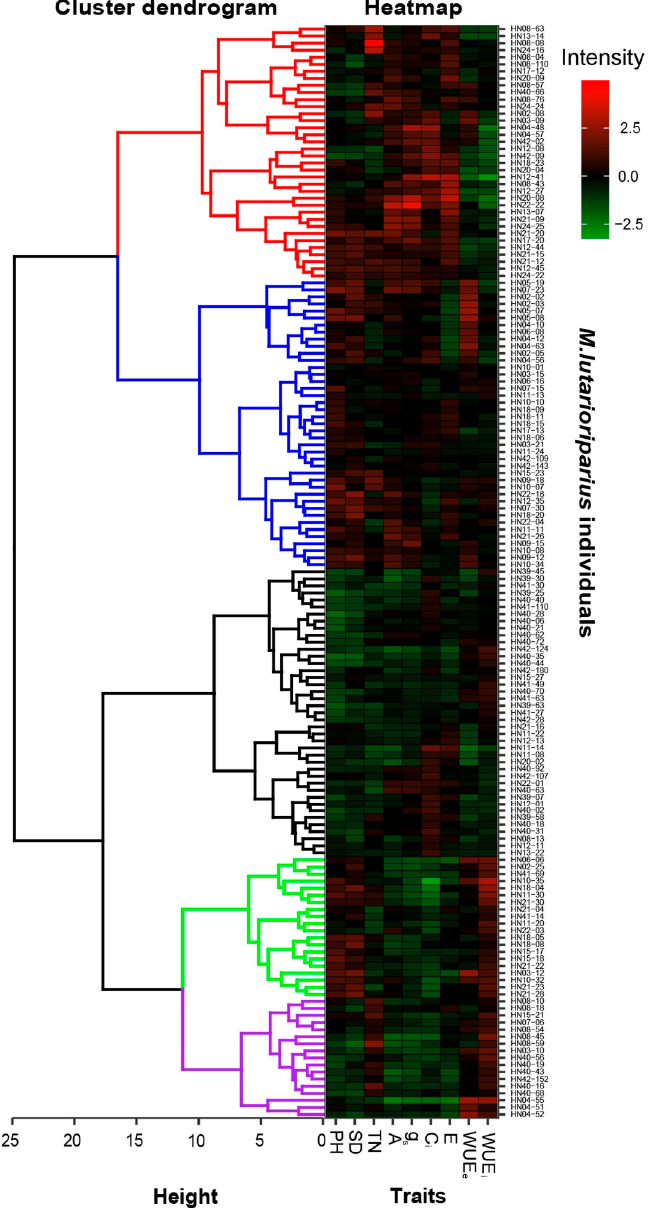
Figure 5. Cluster analysis of 155 individuals survived in both 2012 and 2013. The tree structure on the left presents the 5 groups of individuals and the colored squares on the right present the standardized data of growth traits, photosynthetic parameters, and WUE. The changes in the color in a square from green to red represent the value change of growth traits, photosynthetic parameters, and WUE from low to